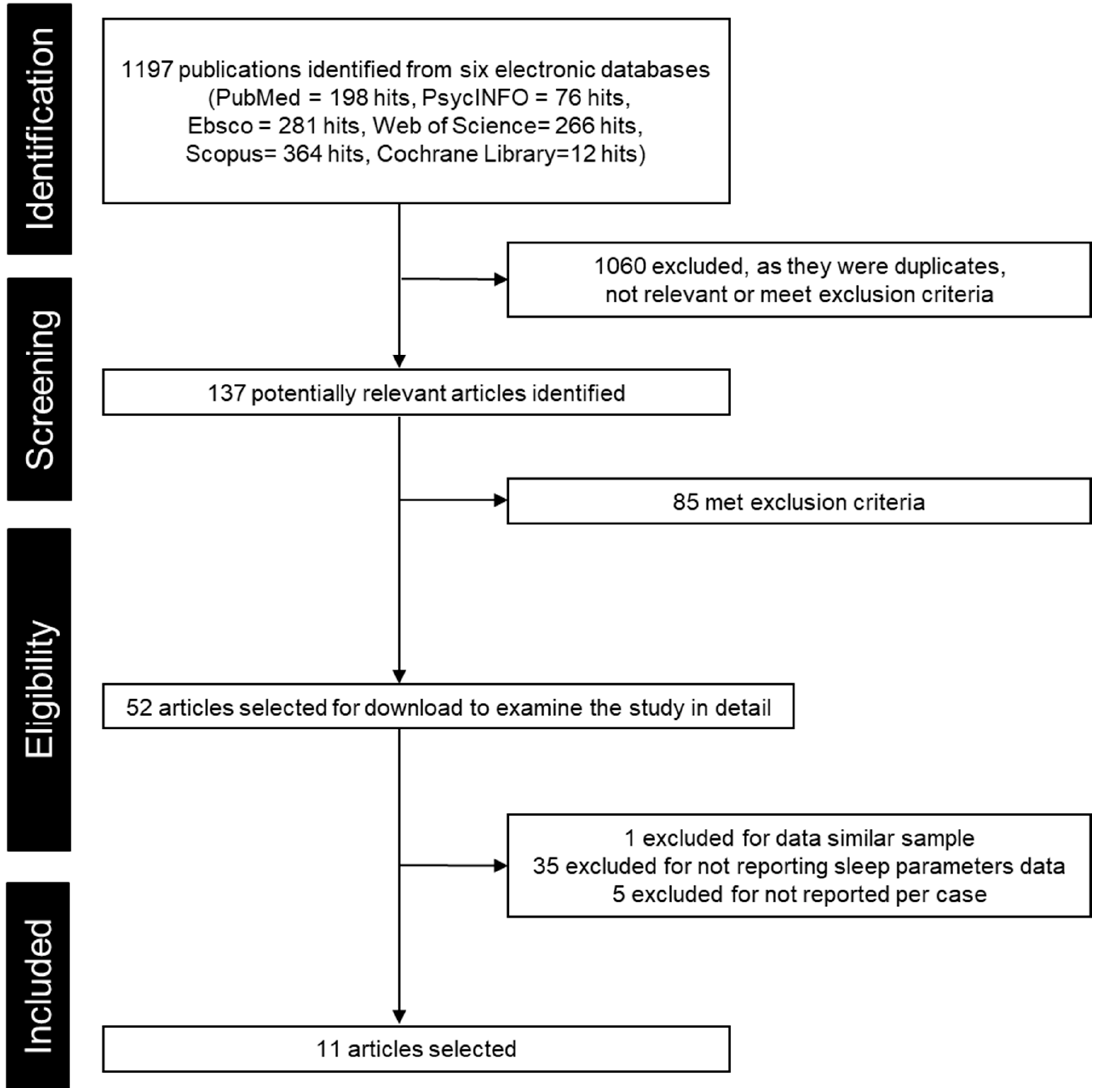
Figure 1. Flowchart of article selection up to the date of 6 February 2022.